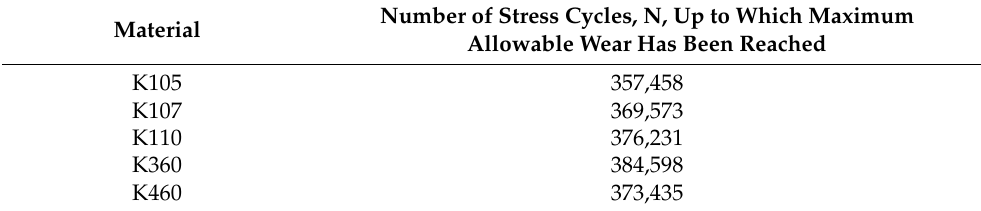
Table 5. Durability of trimming dies made of different materials.